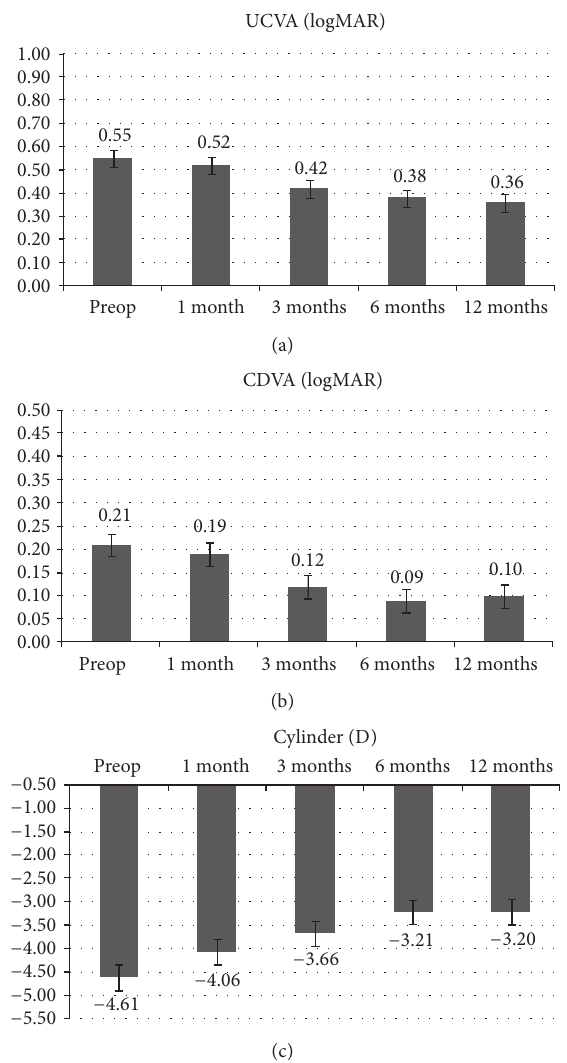
Figure 1: LogMAR average UDVA (a), CDVA (b), and topographic astigmatism (c) values after high-irradiance topography-guided CXL. 1-year follow-up mean topographic astigmatism value signifi- cantly improved from − 4.61 diopters (D) to − 3.20 D (𝑝 < 0.05) .